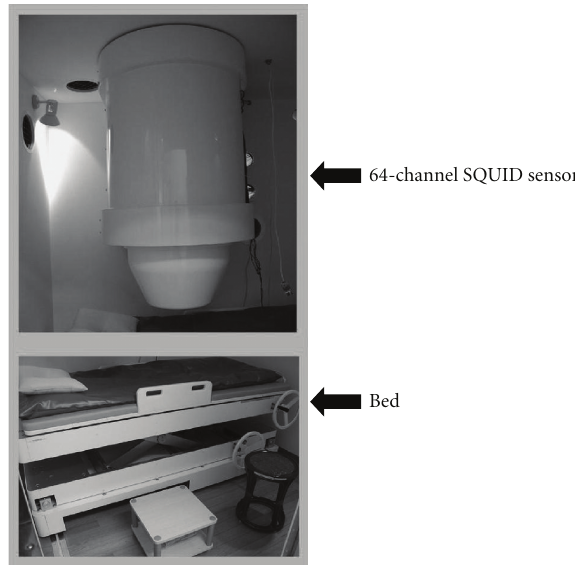
Values are represented as the mean ± SD. NS: not significant.